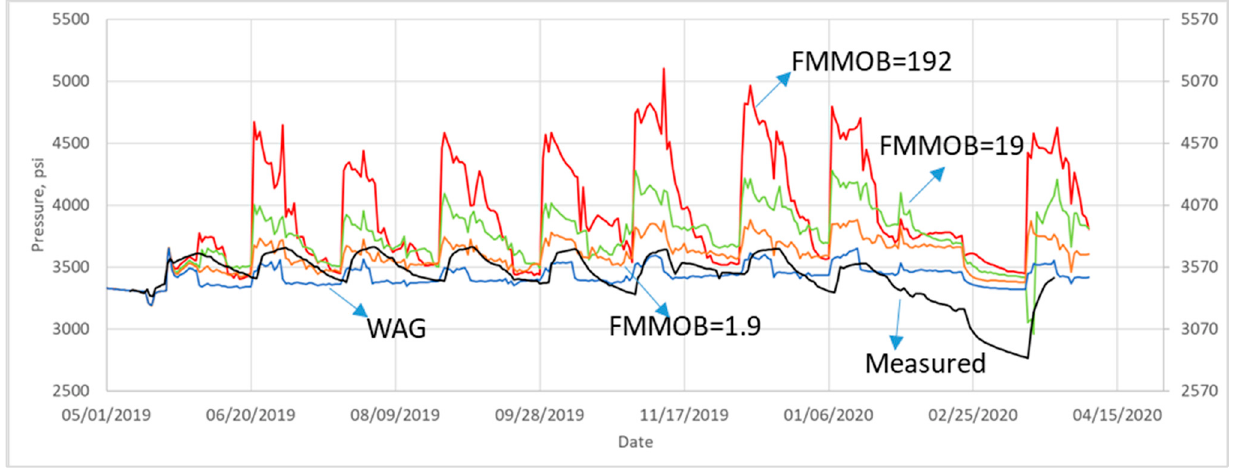
Figure 7. Simulated pressures using different foam strength